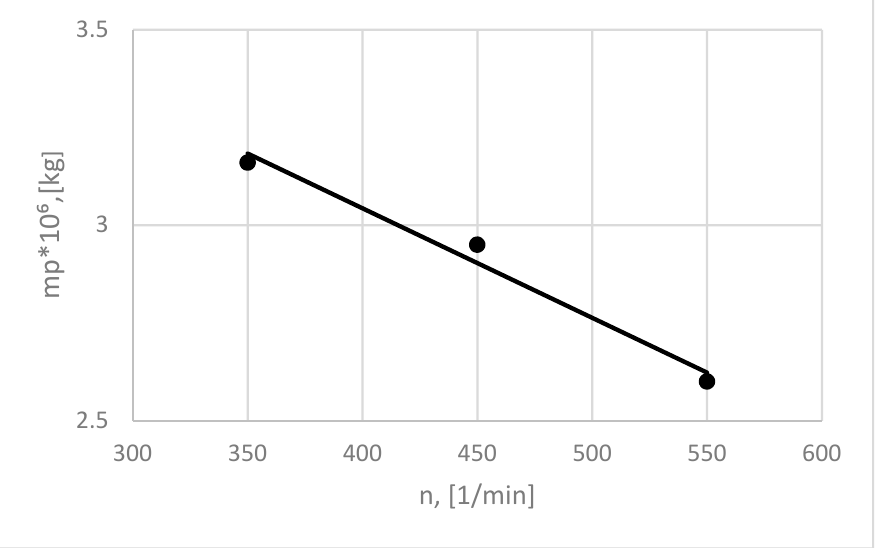
Figure 2. The dependence of the average particle mass m p on the rotation frequency of the rotor n in a high-speed granulator. The line represents calculated values, the points—experimental values. Consequently, Equation (1) is an acceptable basis, including in the analysis of pro- cesses in which the coagulation and crushing of solid particles occur simultaneously. Additionally, the Approximations (12) and (13) can be used for probabilistic estimation of coagulation and particle crushing during the entire time of the process. The dependence f ( m ) = N _ ( t ) A 2 me − Am is flexible enough to correspond with sufficient accuracy to the actual dynamics of changes to the granulometric composition in the periodic mode of operation of the apparatus, or in a continuous process—provided that the design of the apparatus ensures a mode of movement of the material close to ideal